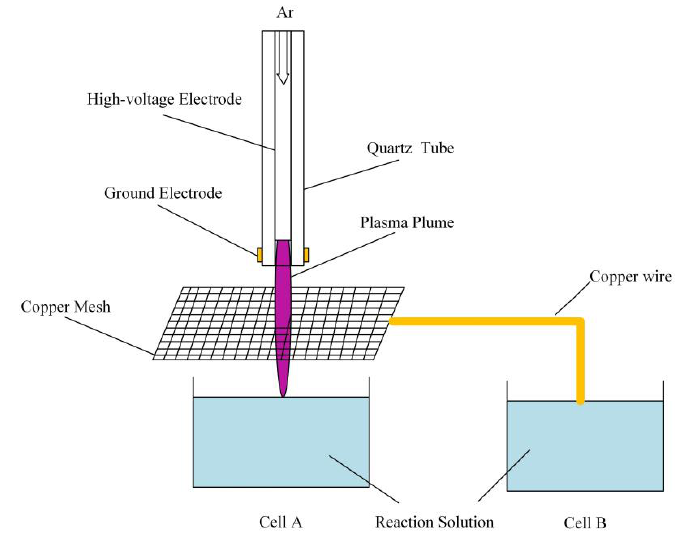
Figure 13. Schematic diagram of the experimental setup.